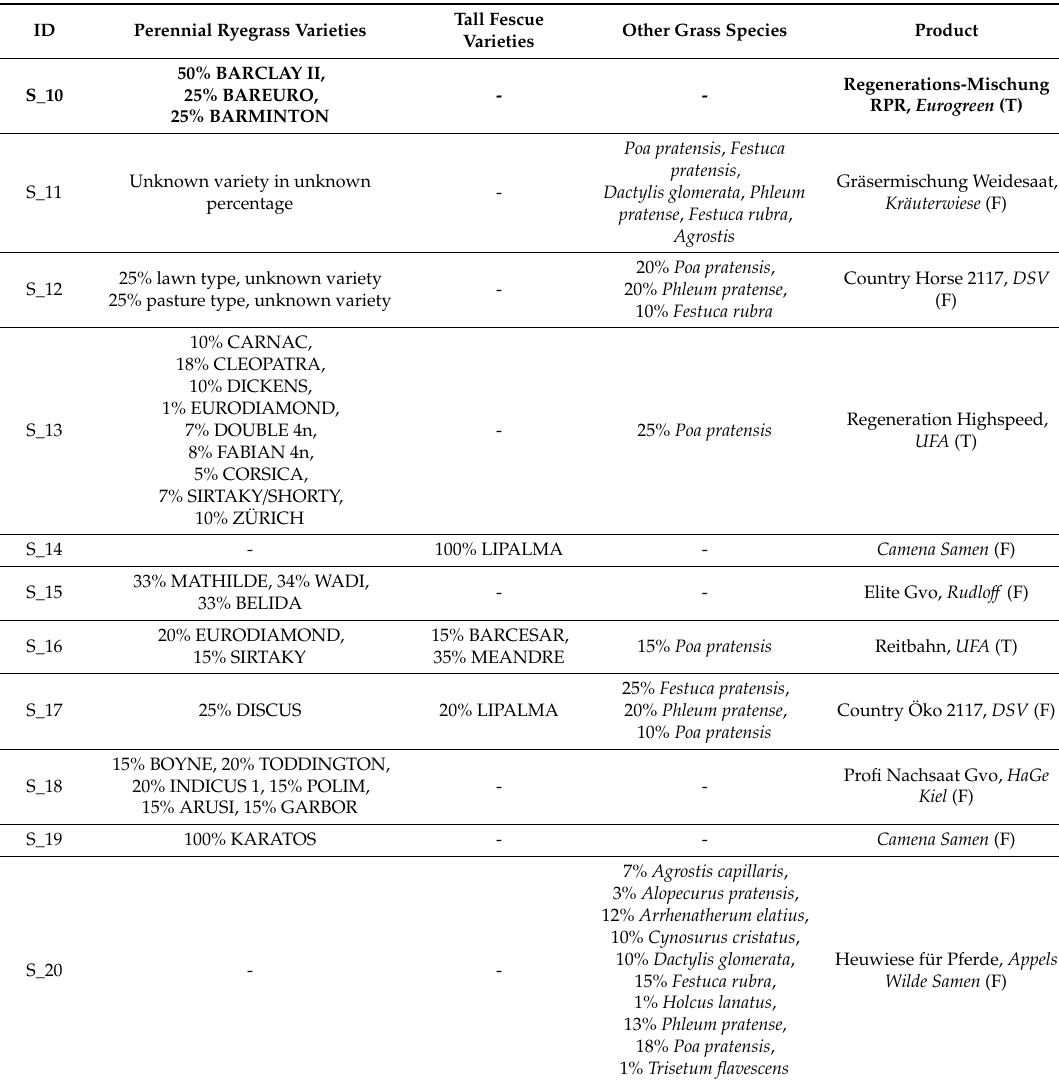
Table 1. Composition of grassland seed mixtures, bold indicate seed mixtures with infections of Epichloë spp. and detected vertebrate toxic alkaloids. Letters in brackets after the product name indicate if seed mixtures are mainly used as forage grass (F) or turfgrass (T) according to supplier information. Supplier names are in italics. Tall Fescue